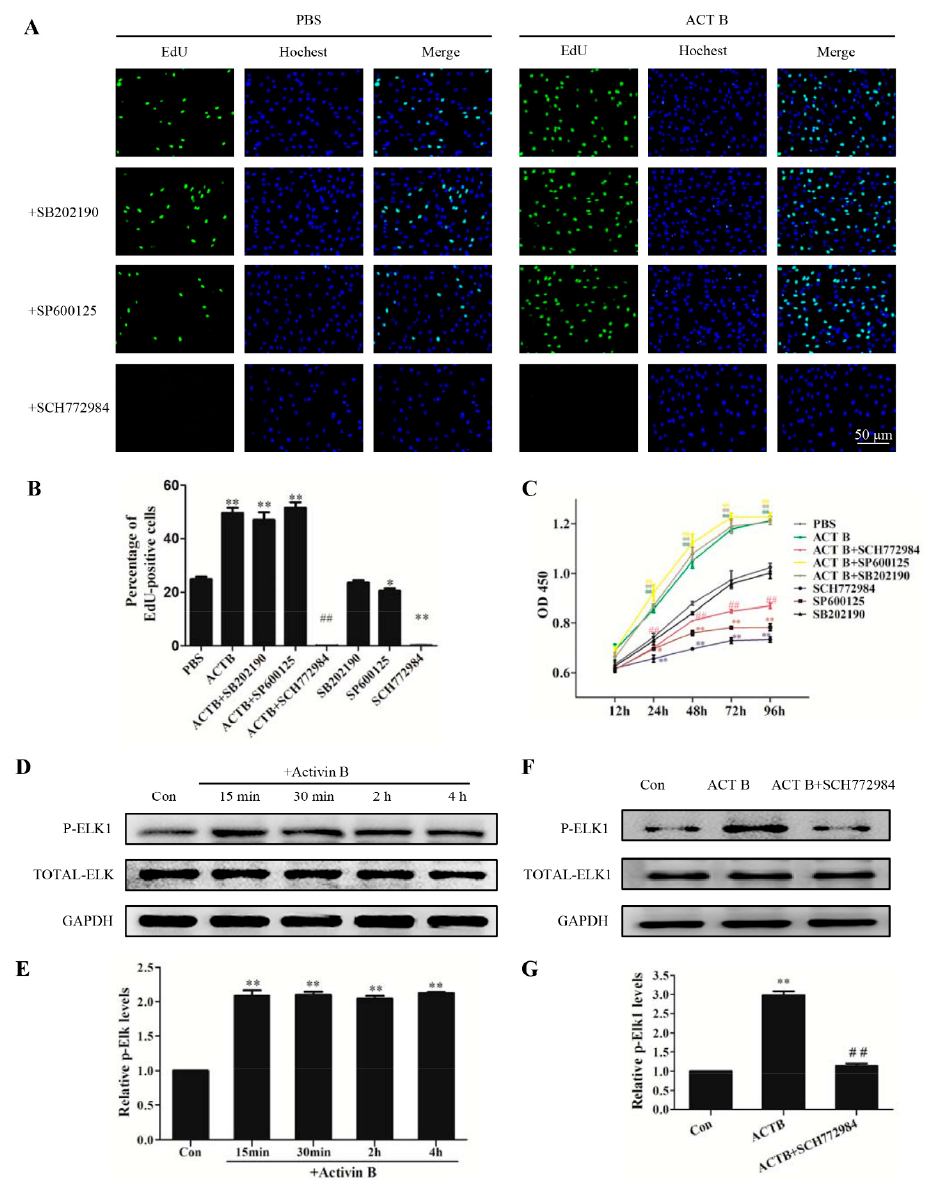
Figure 4. Activin B modulated the cell growth of HHGMCs through the ERK–Elk1 signaling pathway. ( A ) HHGMCs were serum starved for 24 h followed by treatment with SCH772984 (5 µ M), SP600125 (5 µ M), or SB202190 (5 µ M) for 2 h. After treatment with PBS or 10 ng/mL Activin B for 48 h, EdU staining (green fluorescence) was performed. Nuclei were counterstained with Hoechst 33342 (blue fluorescence). ( B ) The percentage of EdU-positive cells was calculated. ( C ) For the CCK-8 assay, HHGMCs were pretreated as ( A ) described. The CCK-8 assay was conducted at 12, 24, 48, 72, and 96 h after Activin B treatment. ( D , E ) The plot and the relative quantification of the expression of phosphorylation of Elk1 in HHGMCs treated with 10 ng/mL Activin B for 15 min, 30 min, 2 h, or 4 h. ( F , G ) The plot and the relative quantification of the expression of phosphorylation of Elk1 in the cells pretreated with SCH772984. * p < 0.05; ** p < 0.01, compared with the PBS group. # p < 0.05; ## p < 0.01, compared with Activin B group. Three independent experiments were conducted per data point. All error bars indicate